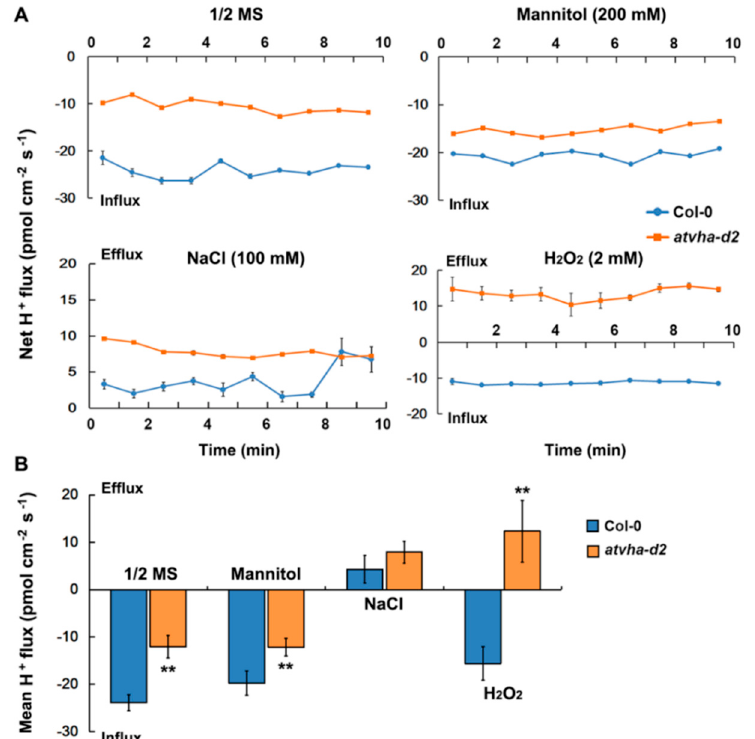
Figure 8. Net H + flux in the roots of Col-0 and the atvha-d2 mutant under multiple stresses. Net (A) and mean ( B ) H + flux in the root elongation zone of Col-0 and atvha-d2 seedlings (7-days-old) treated in 1 / 2 MS and 1 / 2 MS medium with mannitol (200 mM), NaCl (100 mM), and H 2 O 2 (2 mM) for 24 h. Continuous flux was recorded for 10 min. Mean H + flux from six samples ( n = 6). Asterisks indicate a significant di ff erence between Col-0 and atvha-d2 plants (** p < 0.01; Student’s t -test). Error bars represent the SE ( n = 6).